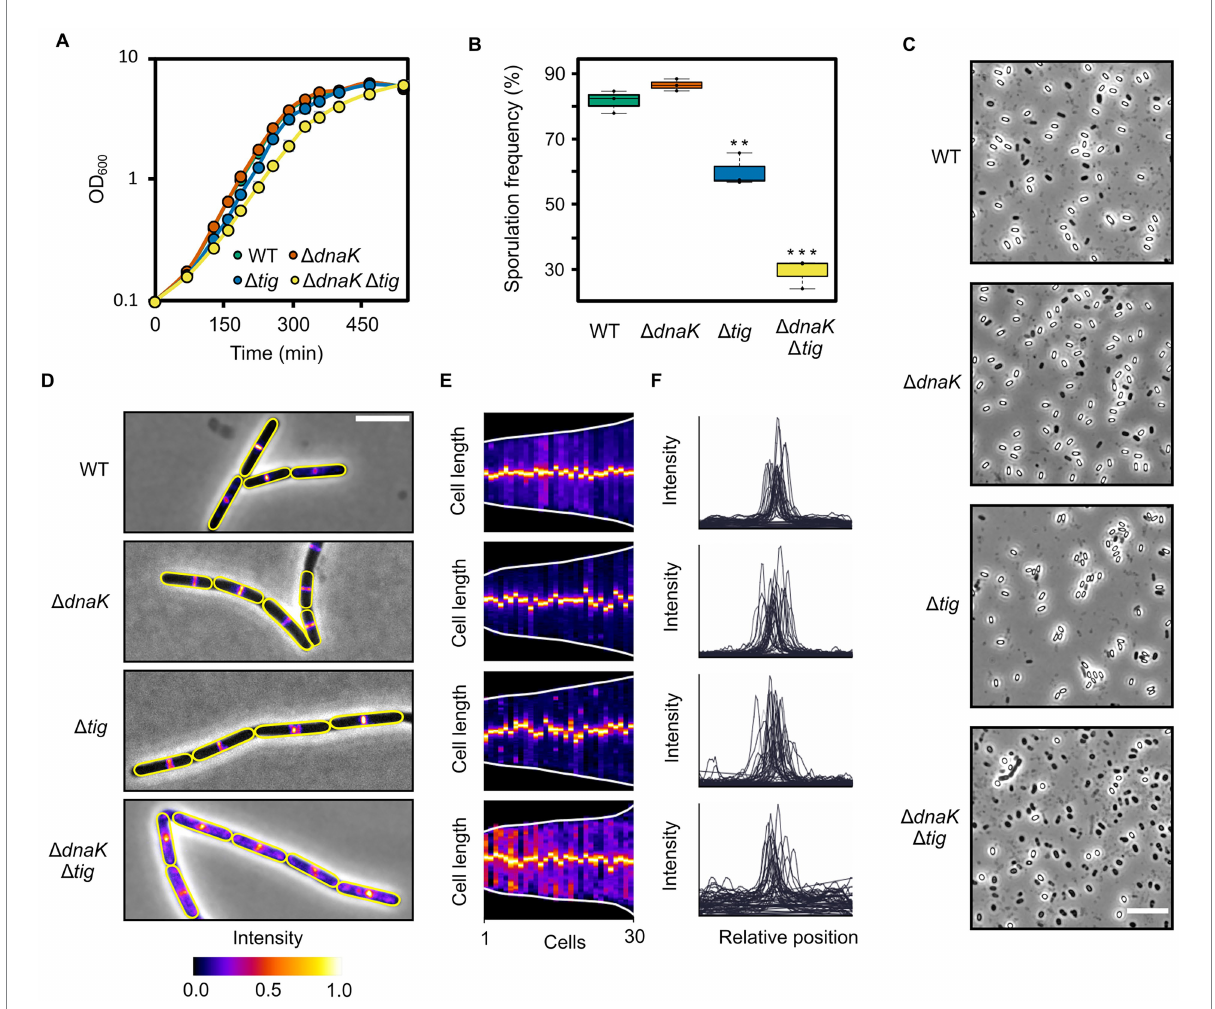
FIGURE 5 Growth, sporulation, and cell division of chaperone deletion mutants. (A) Growth curves of B. subtilis wild-type (1A1), Δ dnaK (LUW876), Δ tig (LUW901), and Δ dnaK Δ tig (LUW878). Cells were grown in a liquid broth medium (NSMPG) at 30 ° C. Each strain was grown in triplicates, and represented are the average OD 600 measurements. Error bars displaying the standard deviation between the triplicates are also represented, but due to the small variation, they are not seen. (B) Sporulation frequencies of the four indicated strains, which were grown in NSMP liquid broth medium at 30 ° C for 48 h. Error bars display the standard deviations for the triplicates. The values were subjected to a two-tailed homoscedastic t -test, comparing each strain with the wild-type (1A1). Significant differences are denoted by two asterisks (value of p < 0.01) or three asterisks (value of p < 0.001). (C) Phase contrast micrographs showing spores of indicated strains. Cells were incubated on NSMP plates for ten days at 30 ° C before imaging. The scale bar represents 10 μ m. (D) Micrographs of the indicated strains expressing mNG-ZapA to visualize the Z-ring. Shown are overlays of the phase contrast and fluorescence channel (mNG). Cells were grown until mid-exponential growth phase in NSMPG at 30 ° C. Cell outlines are in yellow. Scale bar represents 5 μ m. (E) Demographs of the indicated strains displaying the mNG-ZapA fluorescence intensity over the cell length axis. Each slice represents one cell, and cells were sorted by length from shortest to longest. Thirty cells were analyzed for each strain. Demographs were generated by MicrobeJ (Ducret et al., 2016). (F) Fluorescence intensity profiles over the normalized cell length of the indicated strains. For each strain, intensity profiles of 30 cells were plotted. Graphs were generated by MicrobeJ (Ducret et al.,